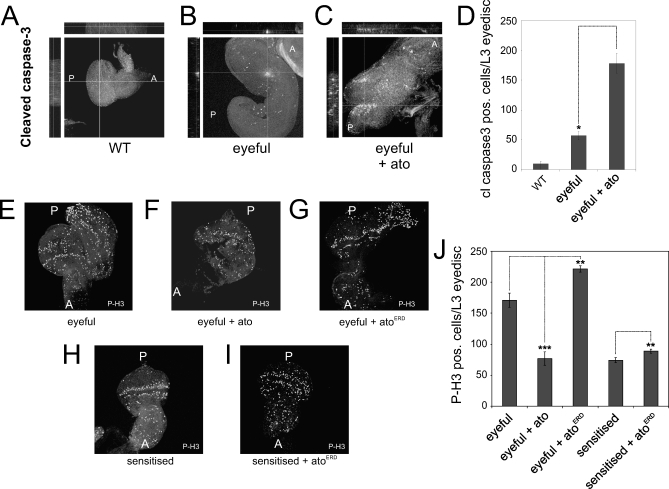
Apoptosis and Proliferation upon ato Loss and Gain of Function(A–C) Staining for cleaved caspase-3 indicates an increase in apoptosis upon overexpression of ato in the eyeful flies. (A) Immunohistochemistry for cleaved capsase-3 in wild type.(B) Cleaved caspase-3 staining in ey-GAL4, UAS-Dl, eyeful/+.
(C) ey-GAL4, UAS-Dl, eyeful/UAS-ato.(D) Quantification of cleaved caspase-3–positive cells per eye disc. Error bars indicate the standard error of the mean, and double asterisks (**) indicate p < 0.05.(E–I) Representative images from third instar eye discs in different genetic backgrounds stained for phospho-Histone H3 (P-H3). (E) ey-GAL4, UAS-Dl, eyeful/+. (F) ey-GAL4, UAS-Dl, eyeful/UAS-ato. (G) ey-GAL4, UAS-Dl, eyeful/UAS-atoERD. (H) ey-GAL4, UAS-Dl/+. (I) ey-GAL4, UAS-Dl/UAS-atoERD. (J) Quantification of proliferating cells in the eyeful and sensitized background upon loss or gain of ato function. Quantification was done for a minimum of ten eye discs per genotype. The chi-square test was used to analyze for significance. Dotted lines connect compared genotypes. Triple asterisks (***) indicate p < 0.001; double asterisks (**) indicate p < 0.01.